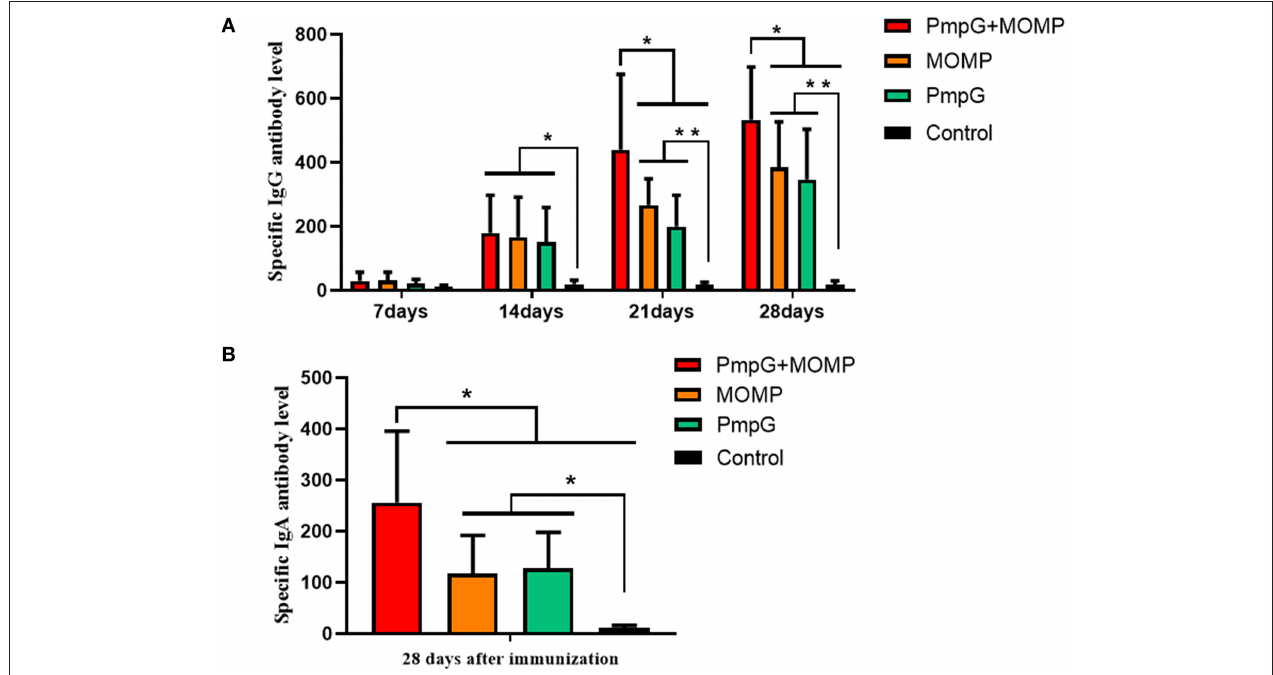
FIGURE 2 | Specific IgG and IgA antibody levels post inoculation into SPF chickens. (A) The PmpGs + MOMP group induced higher IgG antibody levels than the other three groups did from day 21 to day 28 ( p < 0.05). No statistical difference was found between the PmpGs group alone and MOMP group. (B) On day 28, the PmpGs + MOMP group yielded robust IgA antibody levels compared with the PmpGs group alone and the MOMP group ( p < 0.05). The differences were analyzed by ANOVA (* p < 0.05, ** p <